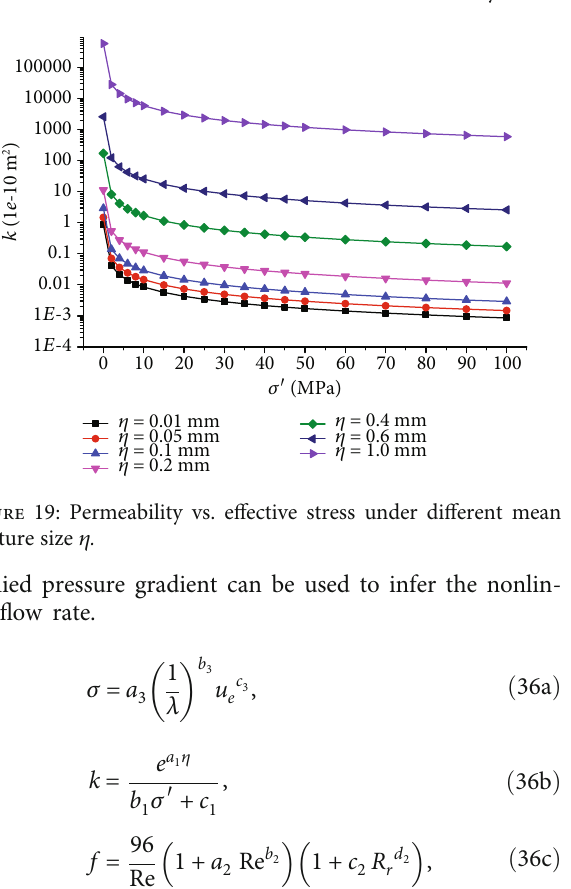
Figure 18: Parametric sensitivity and comparison of proposed friction factor models.